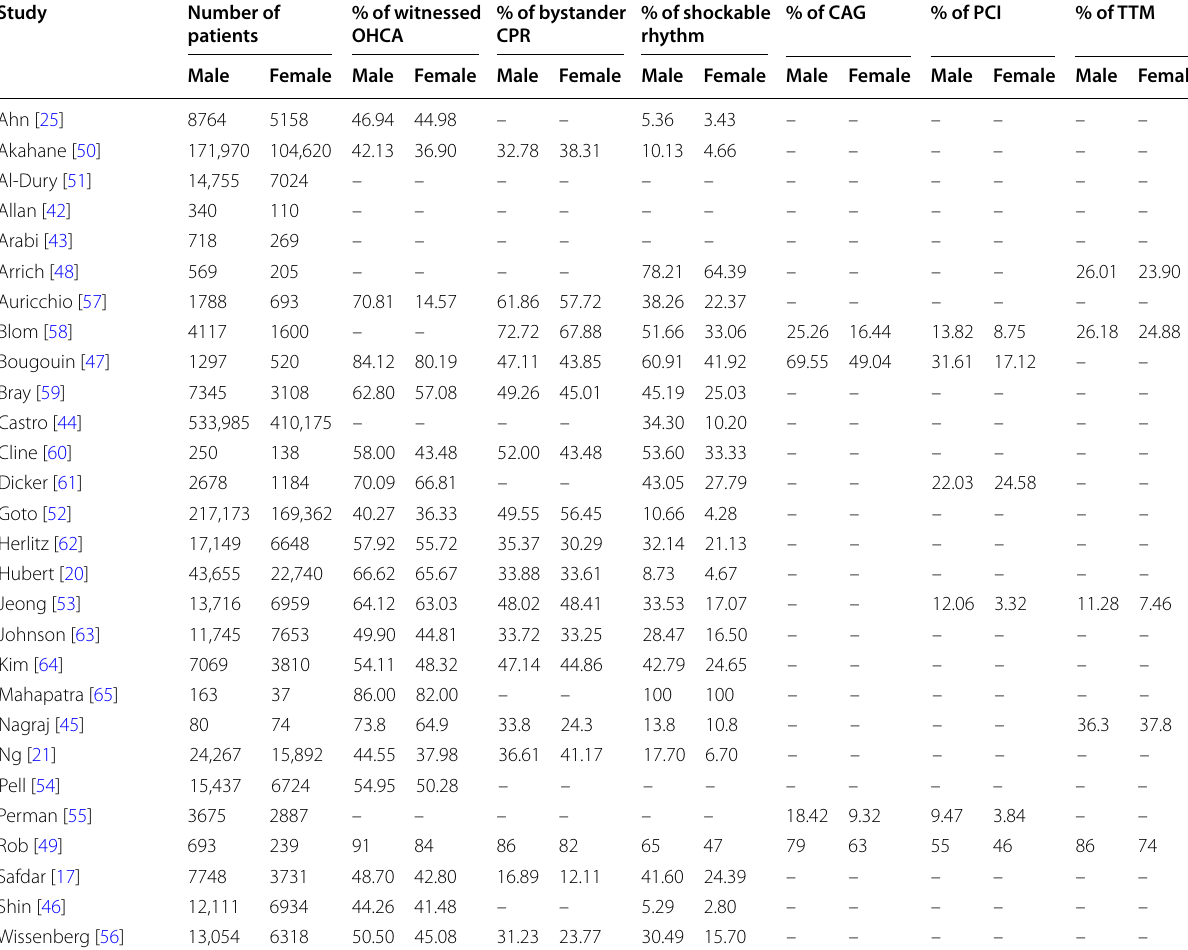
Table 1 Description of the included